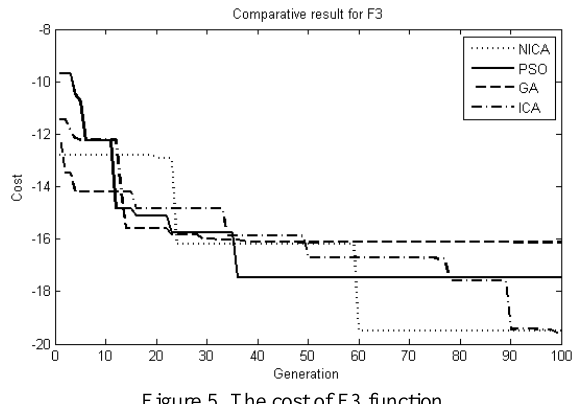
Figure 5. The cost of F3 function.